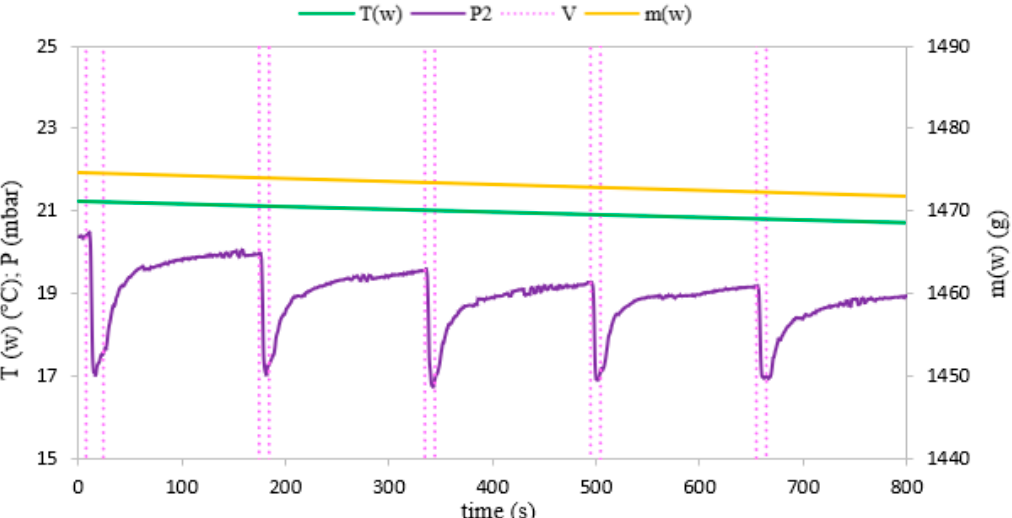
Figure 6. The changes of pressure, temperature and mass of evaporated water with time profiles in the evaporator corresponding to fixed bed conditions.